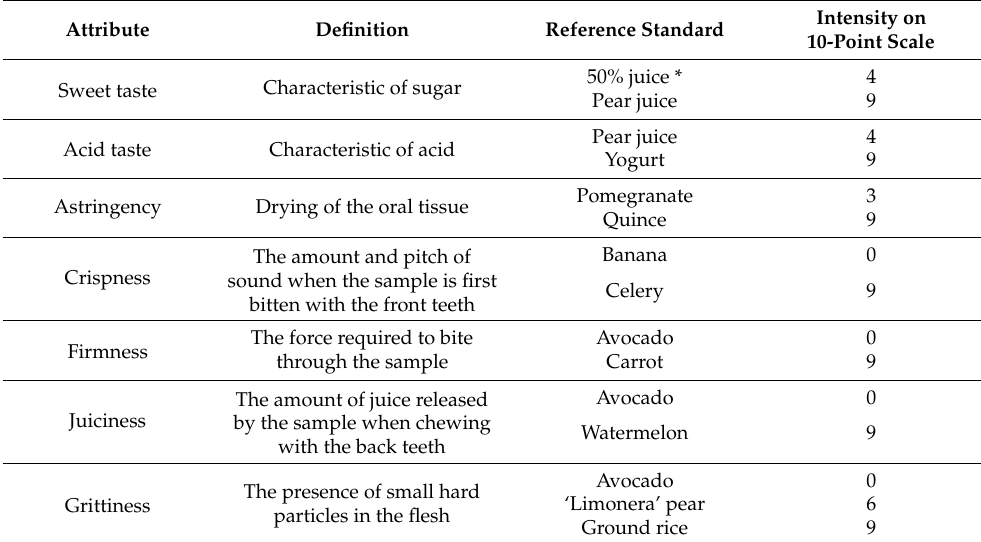
Table 1. Descriptors and standard references used for sensory evaluations of pear attributes.